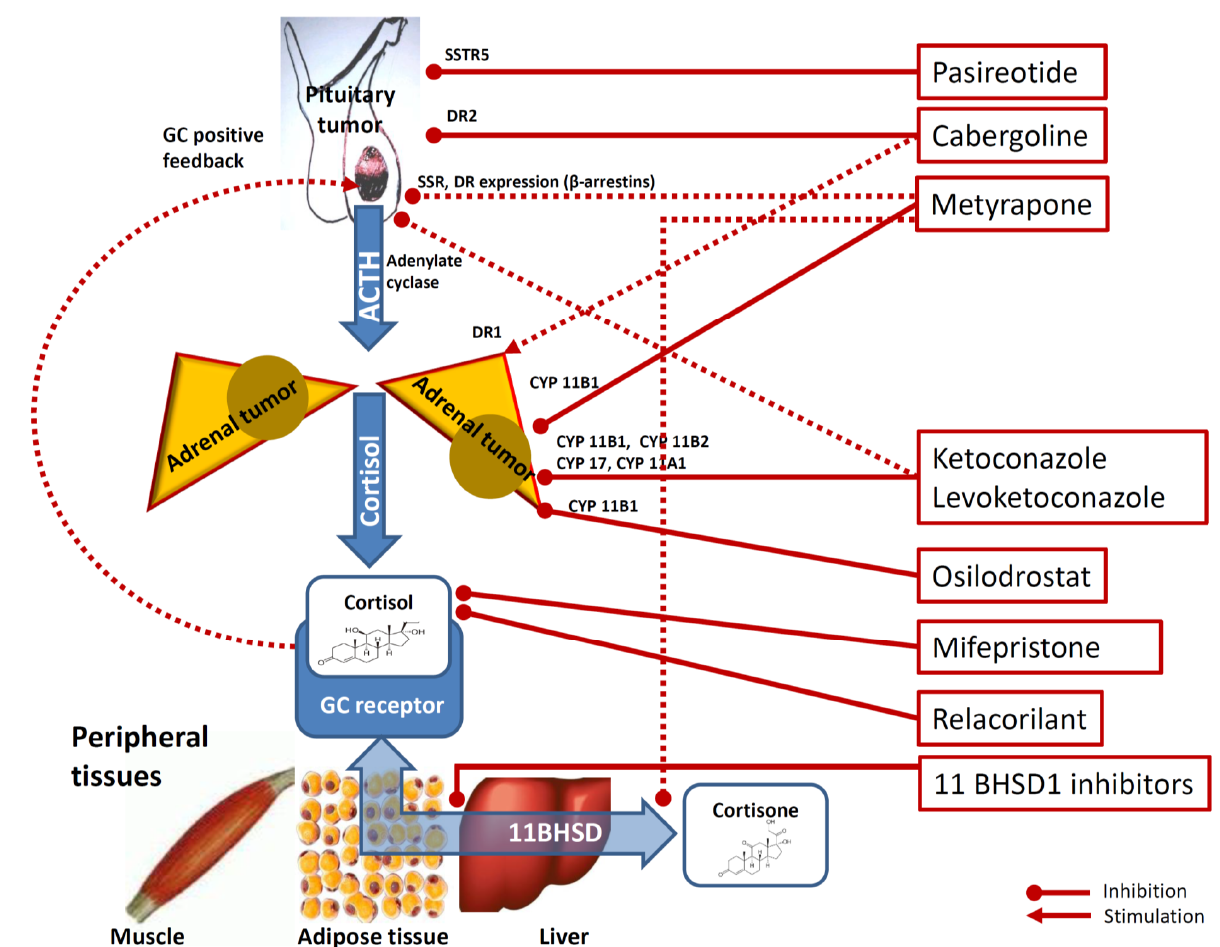
Figure 1. Mechanisms underlying the effects of medical therapy of hypercortisolism. Footnotes: Cabergoline inhibit pituitary corticotrophs via dopamine receptor type 2 (DR2). Cabergoline is also thought to exert a stimulatory role on cortisol